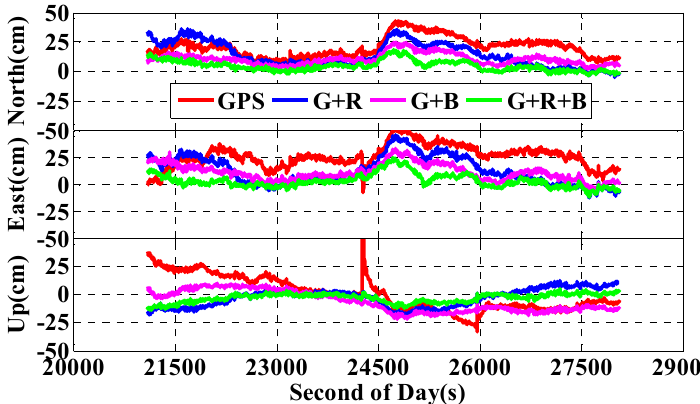
Figure 6. Position offsets time series in navigation frame (North-East-Up) calculated by making differences between the references values and the PPP solutions using the single- (GPS) and the multi-GNSS (G + R, G + B, and G + R + B) data. Remote Sens. 2016 , 8 , 553 11 of 19